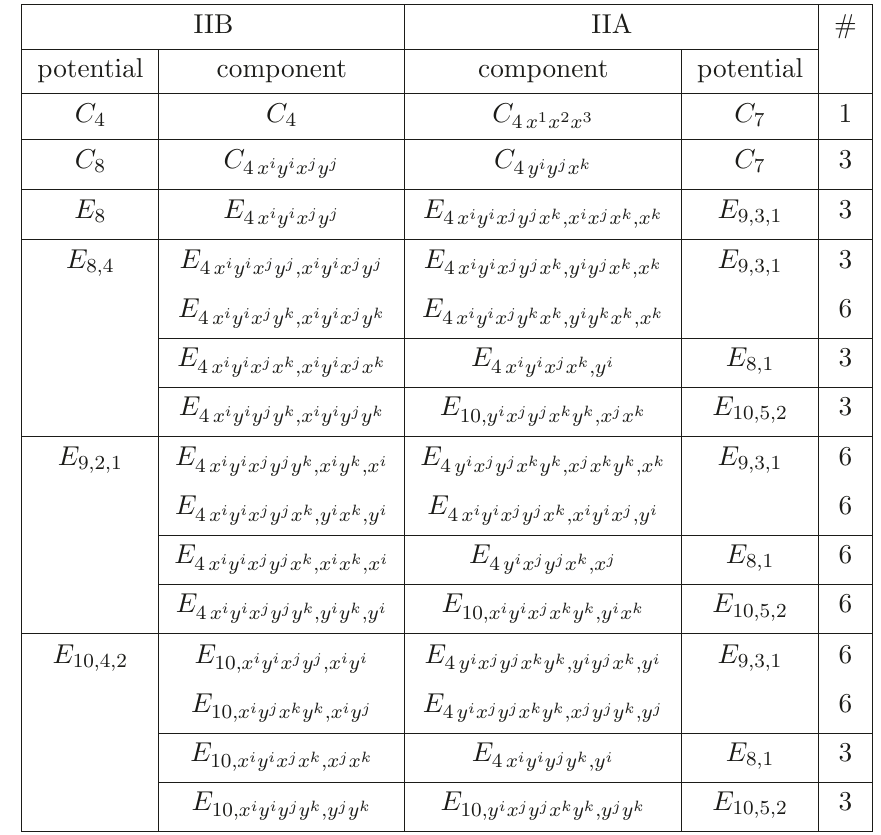
Table 4 . The α = − 1 and α = − 3 branes that can be included in order to cancel the tadpoles generated by the fluxes. To avoid cumbersome notations, in all terms we have not specified the sets of ten indices. Moreover, the indices i, j, k are always meant to be all different. In the last column we give the number of independent components for each potential, which corresponds to the number of different branes. There are in total 4 α = − 1 branes and 60 α = − 3